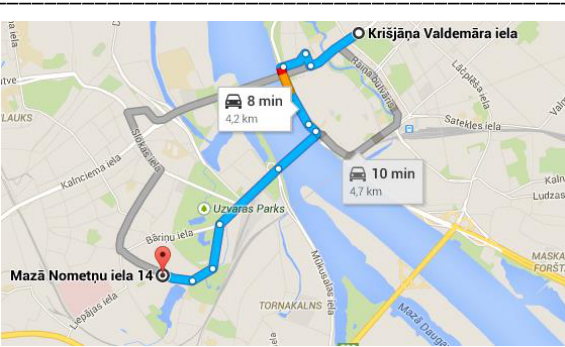
Fig. 5. Routes in the heavy traffic areas in Riga (Latvia).